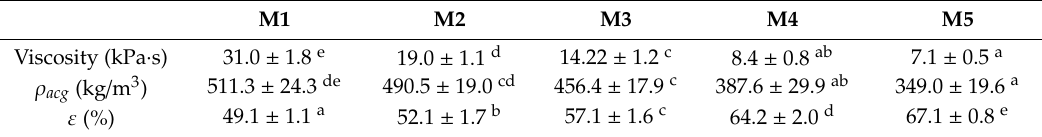
Table 2. Viscosity, density ( ρ ) and gas hold-up ( ε ) of the aerated CBJ–gelatin